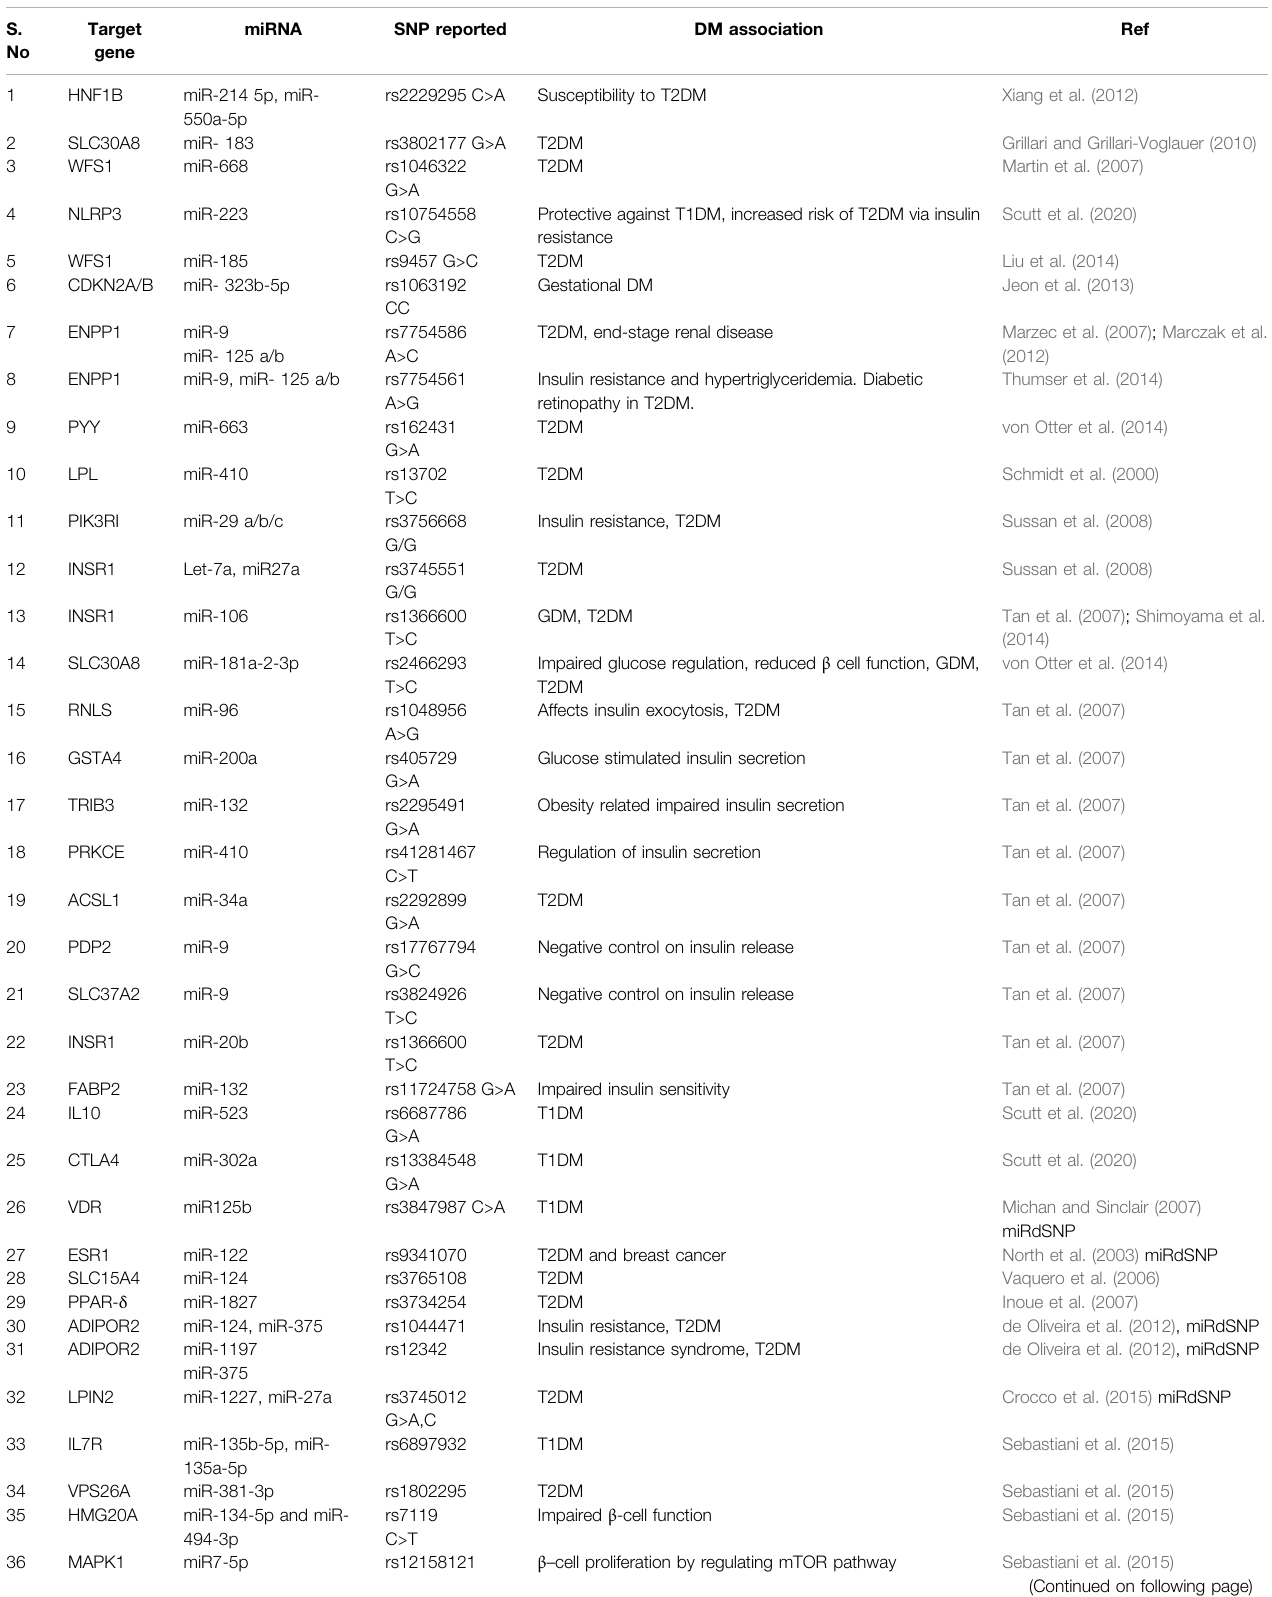
TABLE 4 | SNPs reported in 3 ′ UTR of miRNA target genes in